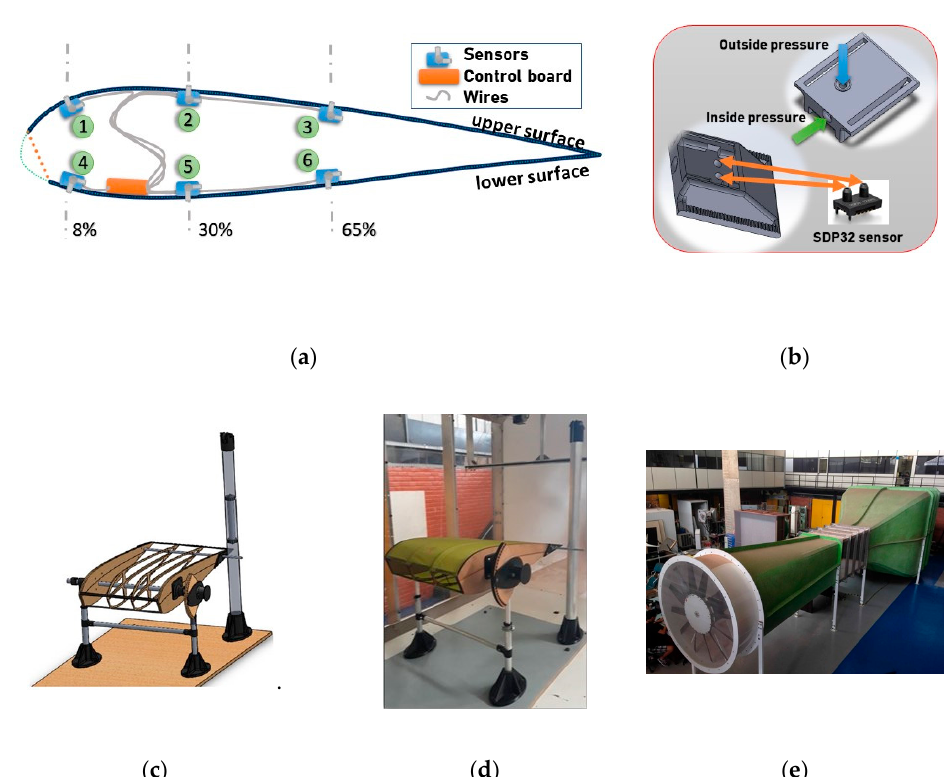
Figure 1. ( a ) Sensors’ strip scheme; ( b ) sensor module with case; ( c ) test bench skeleton; ( d ) assembled prototype; ( e ) wind ‐ tunnel.